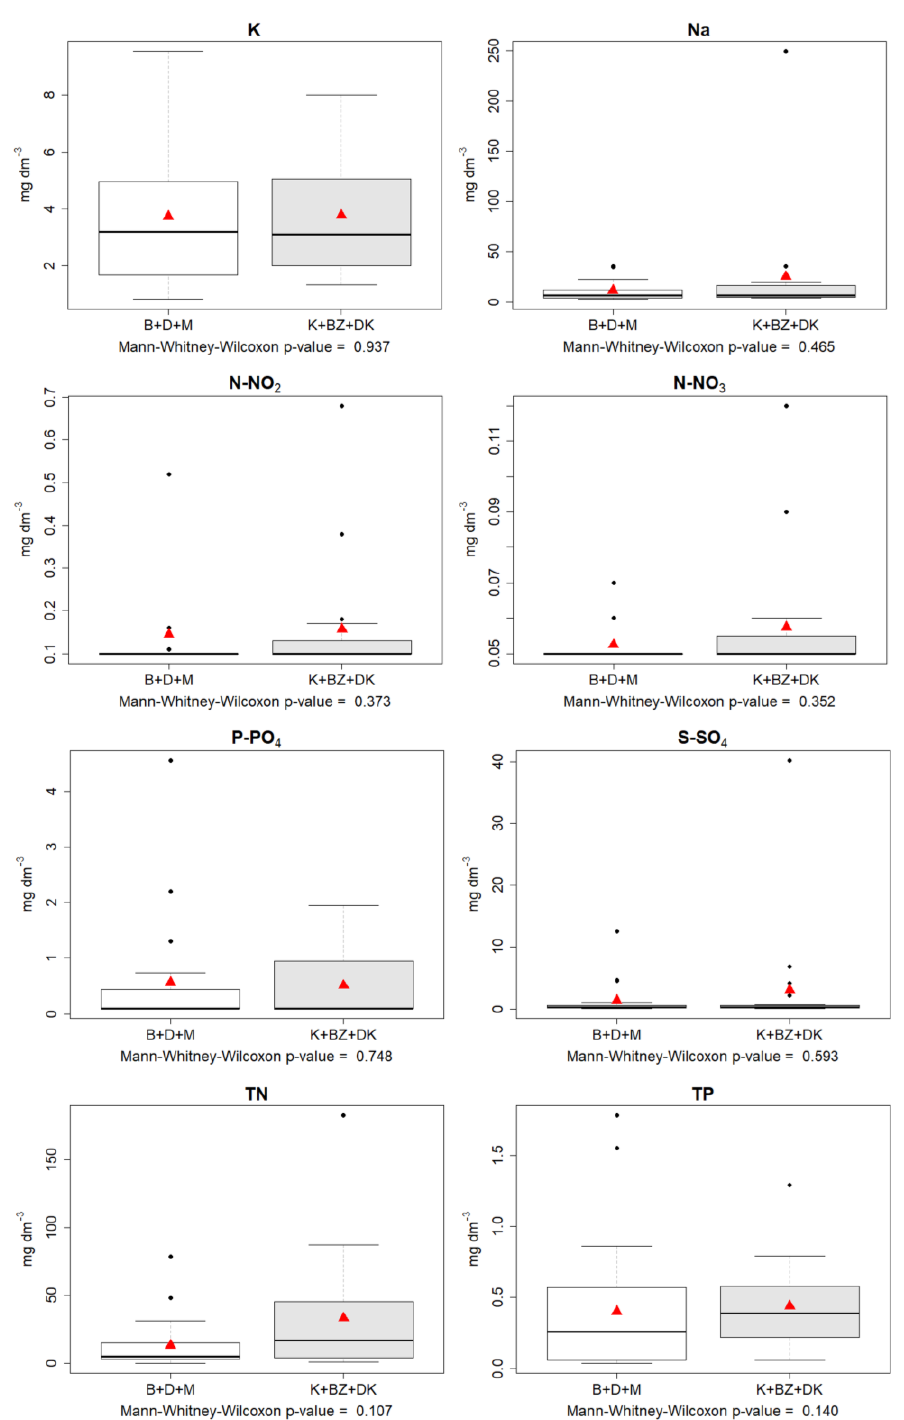
Figure 4. Distribution of values of the other investigated physicochemical properties of piezometric groundwater at the Comarum palustre study sites in 2011–2013, at the study sites Lake Bikcze (B), Lake Karaśne (K), Lake Długie (D), Lake Moszne (M), the mid-forest bog Blizionki (BZ) and the Dekowina (DK) wetland sanctuary. Mann-Whitney-Wilcoxon p-values indicate significance level of differences between site groups. In each boxplot, the box represents the first and third quartiles and the horizontal line dividing the box represents the median. The mean is indicated by the filled red triangle. The whiskers extend to the most extreme observations that are located no more than 1.5 times the interquartile range away from the box. Any observation not included between the whiskers is considered an outlier and is represented by a black dot along the whisker-axis. When there are no outliers, the whiskers terminate at the minimum and maximum